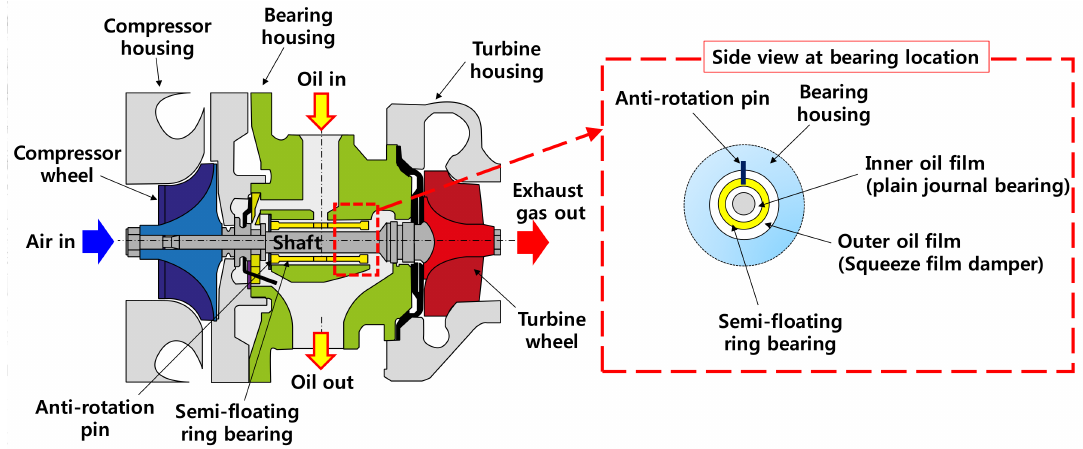
Figure 1. Schematic view (not to scale) of automotive turbocharger (TC) supported on semi-floating ring bearing (SFRB). Right inset figure depicts schematic view (not to scale) of